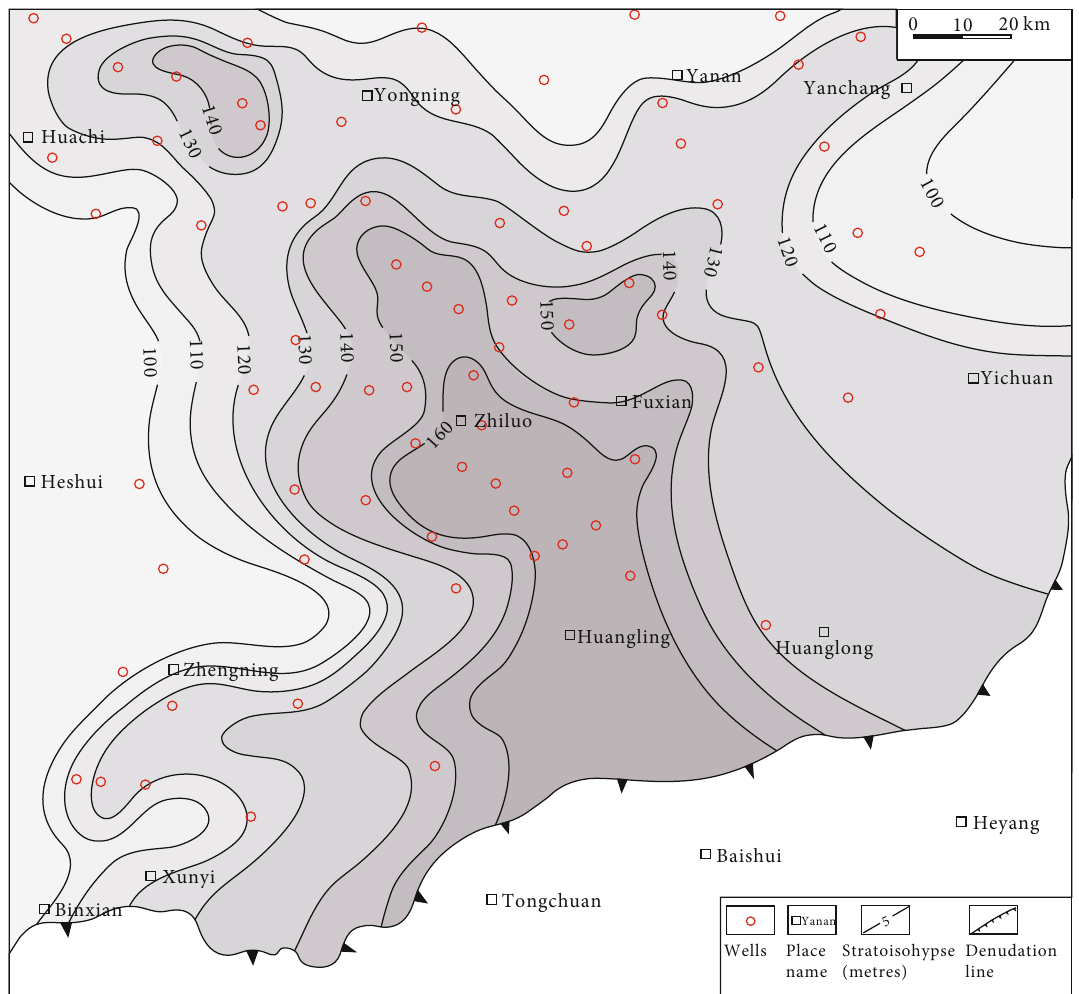
Figure 3: Strata thickness map of Chang 7 interval in southeast Ordos